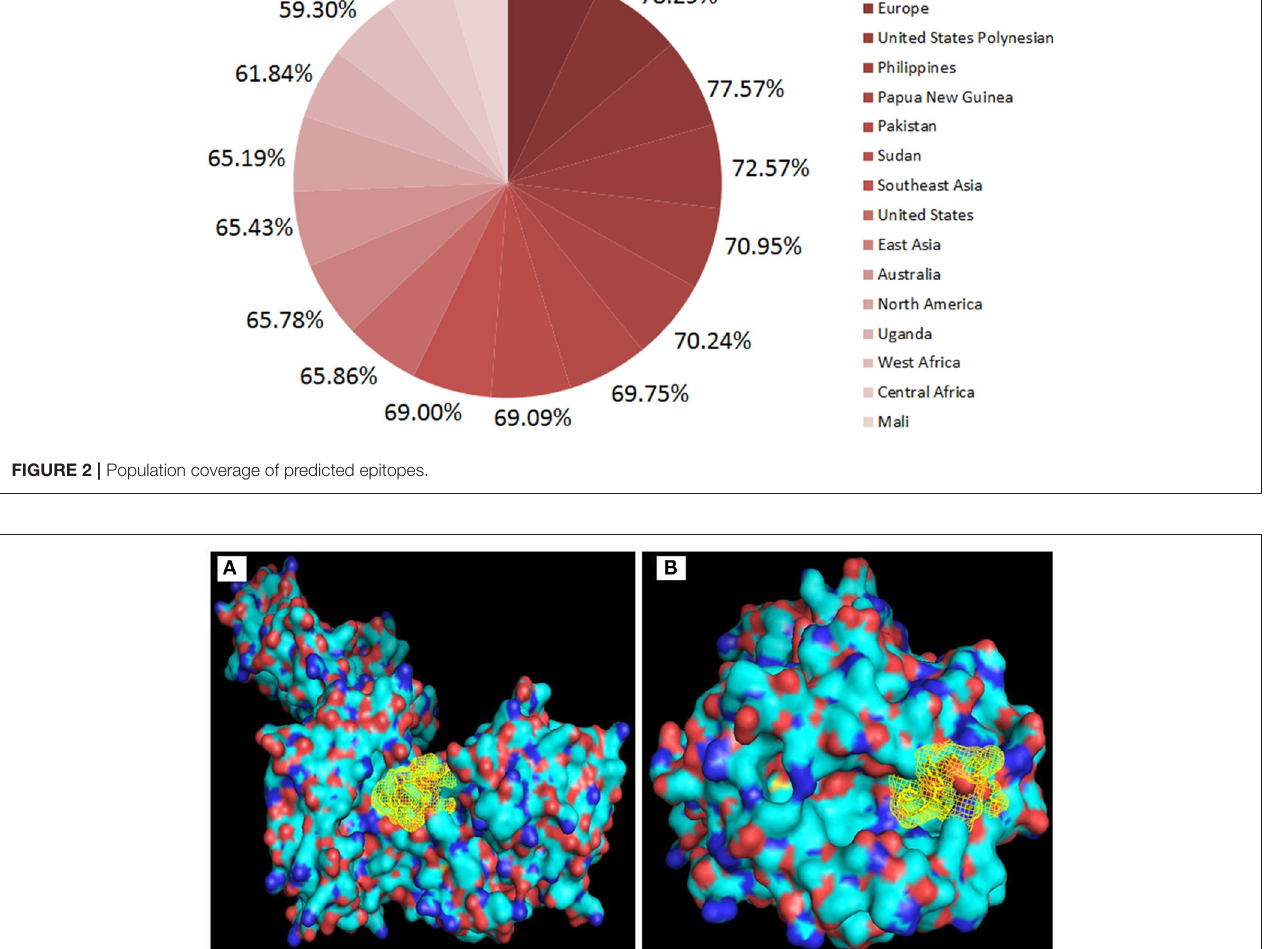
Frontiers in Chemistry |